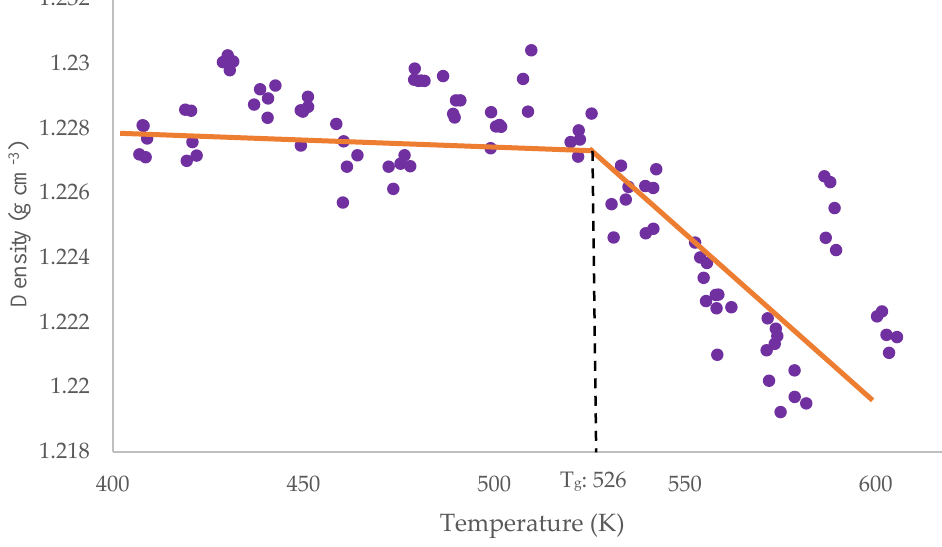
Figure 6. Density against temperature plot for a cured 1.5:1 F:P ratio model. T g is observed at the gradient change as 526 K.